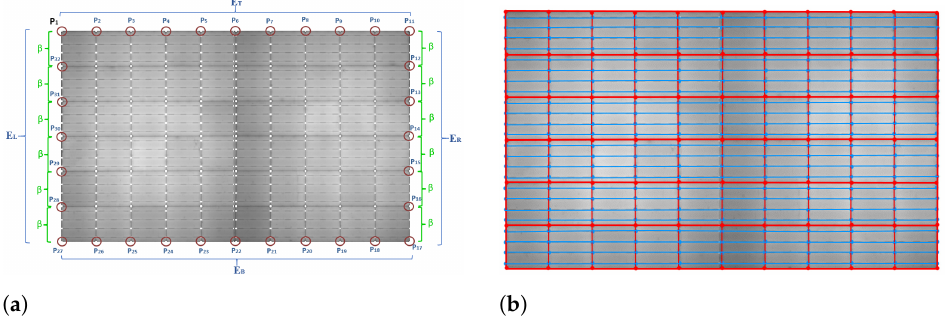
Figure 11. Gridlines and busbars identification. ( a ) Location of boundary edge points. ( b ) Plotting gridlines and